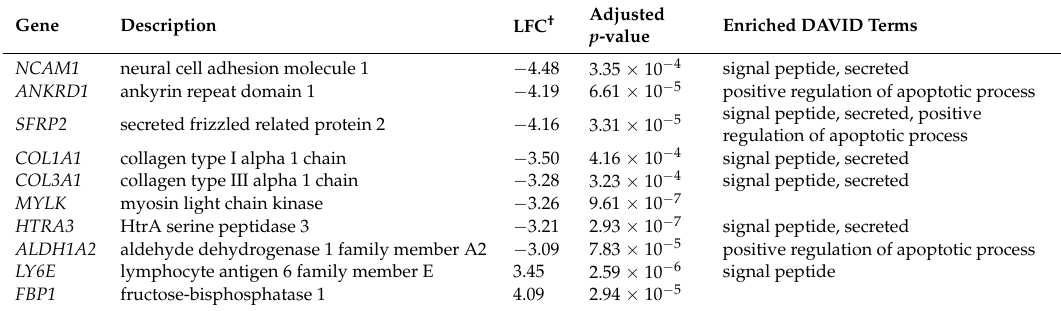
Table 2. Genes that are differentially expressed only during the persistent phase of FMDV